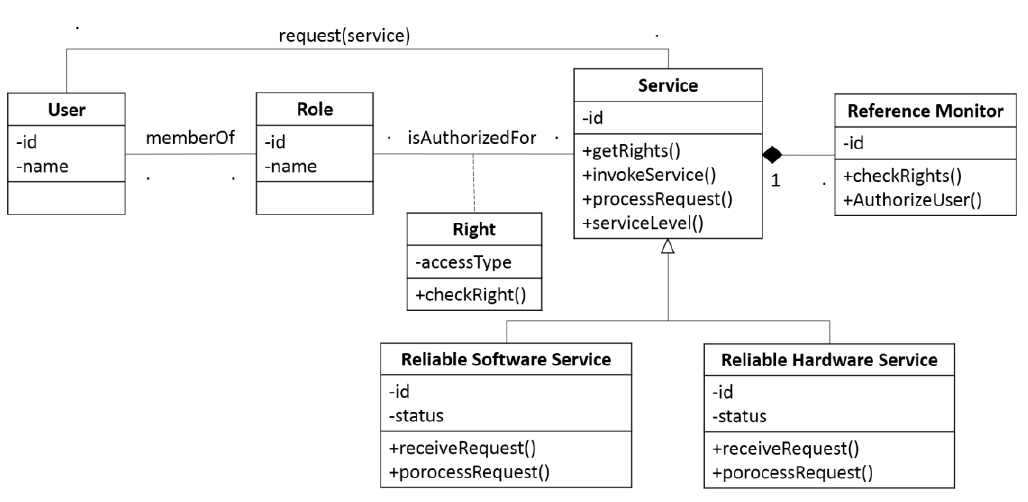
Figure 20. Class diagram for the Secure Reliability Pattern.